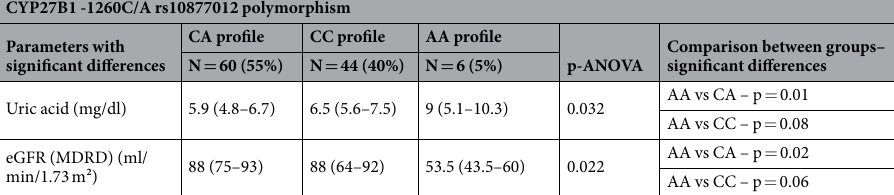
Table 4. The significant differences in CYP27B1 -1260C/A rs10877012 polymorphism. Presented values: median (Q25-Q75). ABBREVIATIONS: eGFR MDRD – estimated glomerular filtration rate on the basis of the study Modification of Diet in Renal